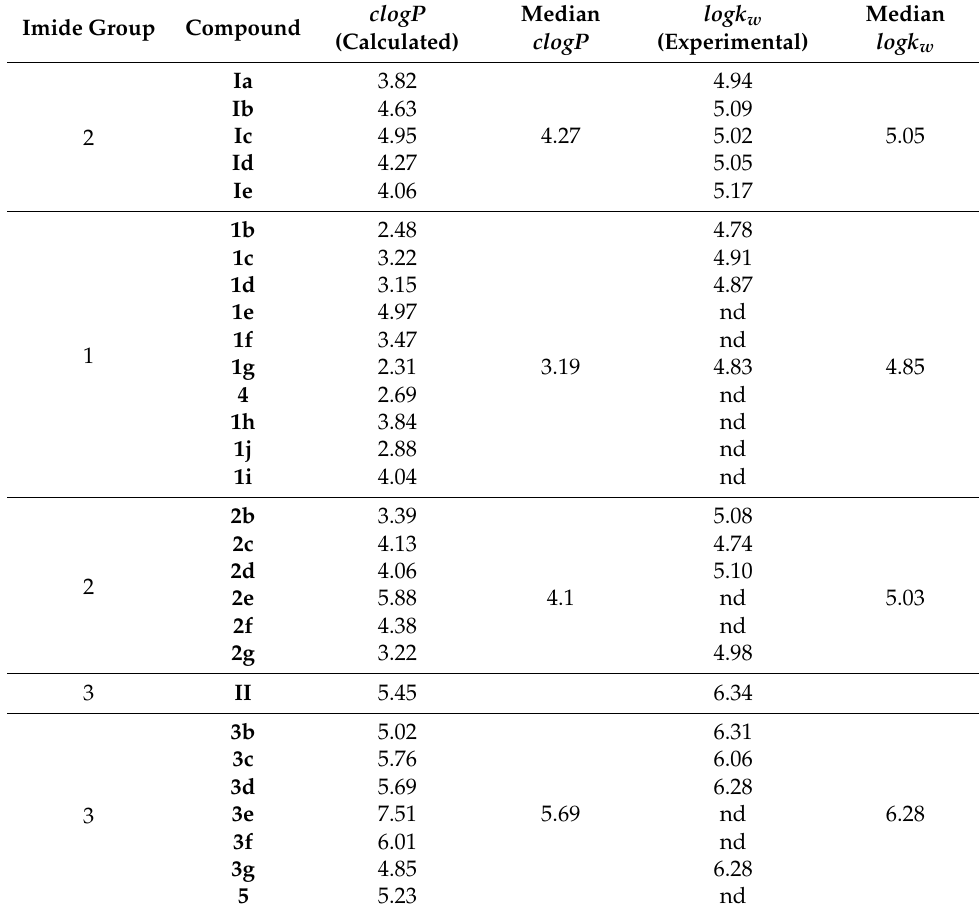
Table 1. Calculated ( clogP ) and experimental ( logk w ) parameters of lipophilicity for synthesized compounds. nd—not